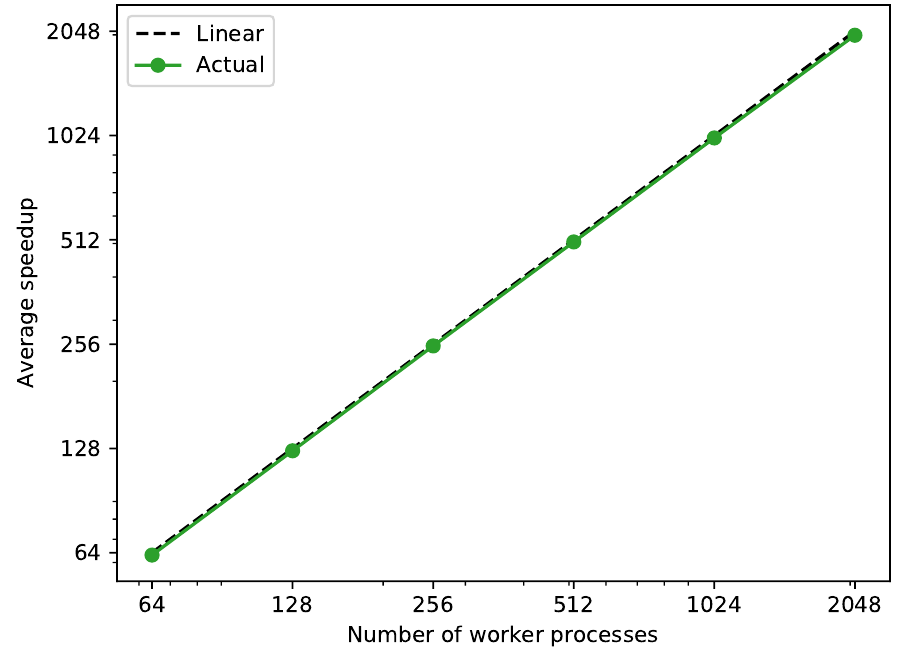
Figure 12. Average speedup against sequential simulation of the 10,000 scenarios generated in test case 4 with a different number of worker